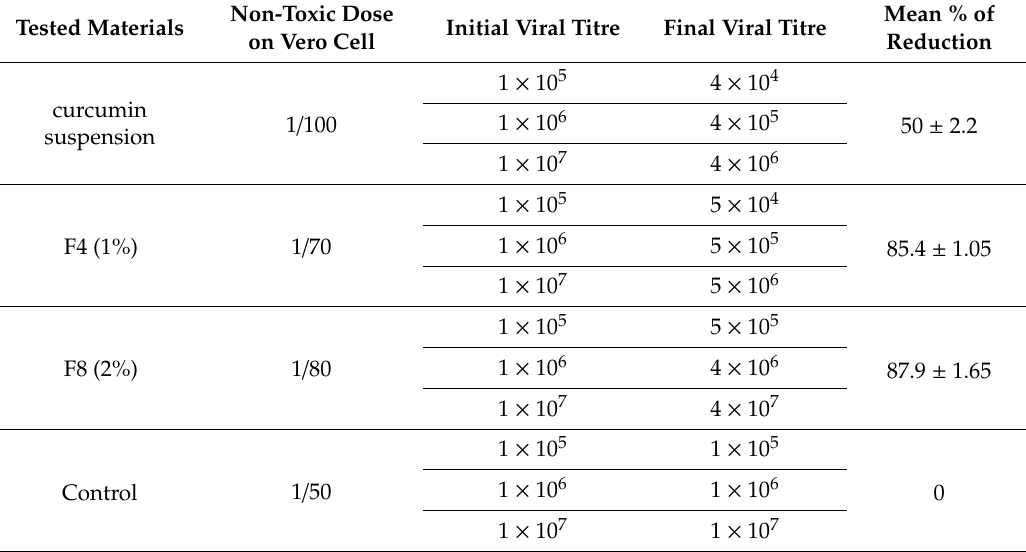
Table 3. The e ff ect of pretreatment of Vero cells with curcumin proniosomal gel formulae on HSV-1